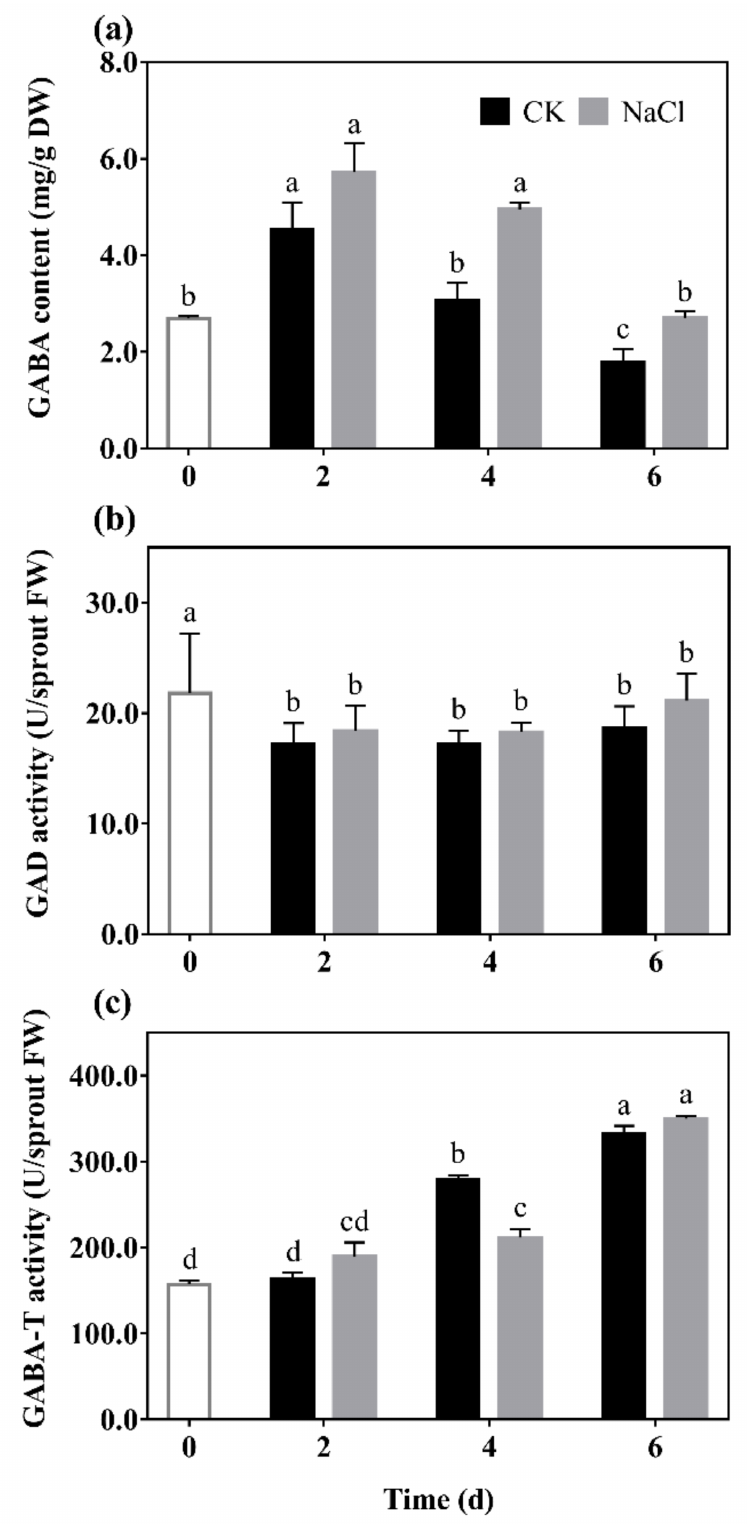
Figure 1. The effect of NaCl on GABA content ( a ), GAD activity ( b ), and GABA-T activity ( c ) of barley seedlings. Barley seedings were cultured under CK and N treatments, respectively. Sampling was performed on day 0, 2, 4, and 6, respectively. Bars represent standard deviation of means ( n = 3), and means with different lower case letters were significantly different ( p < 0.05). Two-way ANOVA was